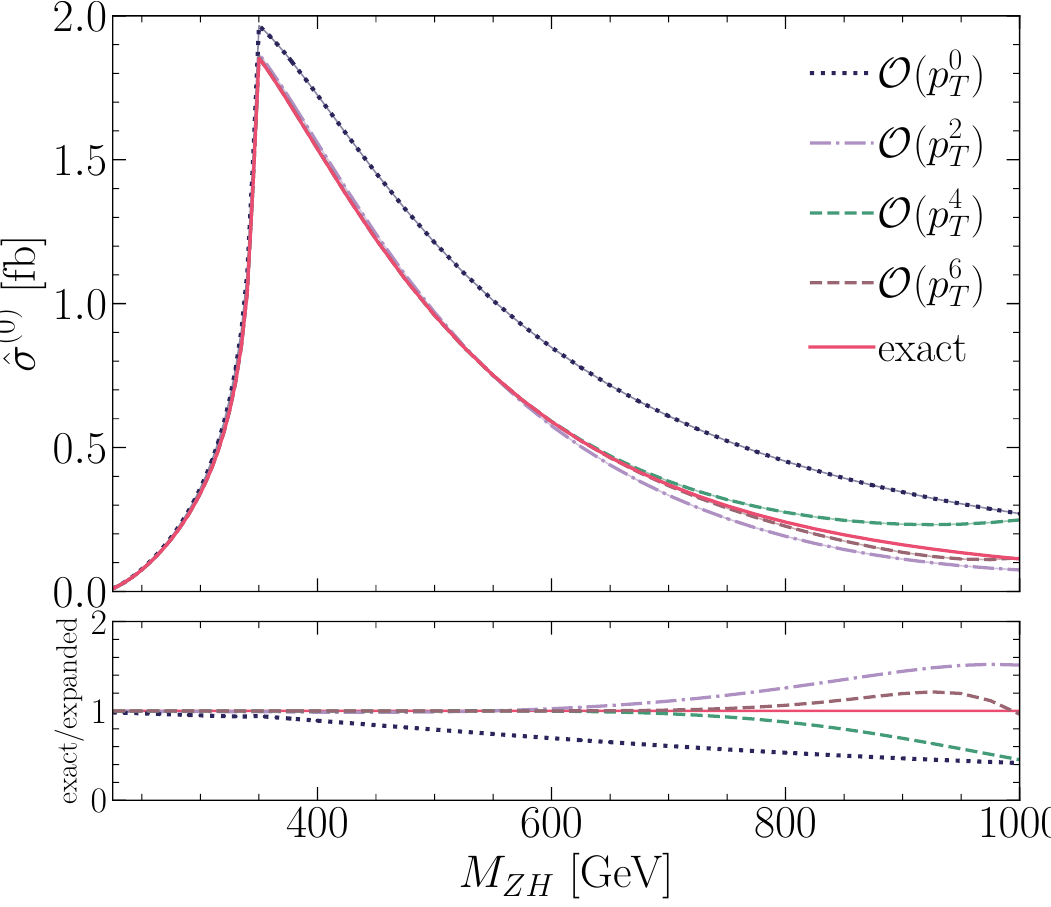
Figure 2 . LO partonic cross section as a function of the invariant mass M ZH . The full result (red line) is plotted together with results at different orders in the p bottom part, the ratio of the full result over the p